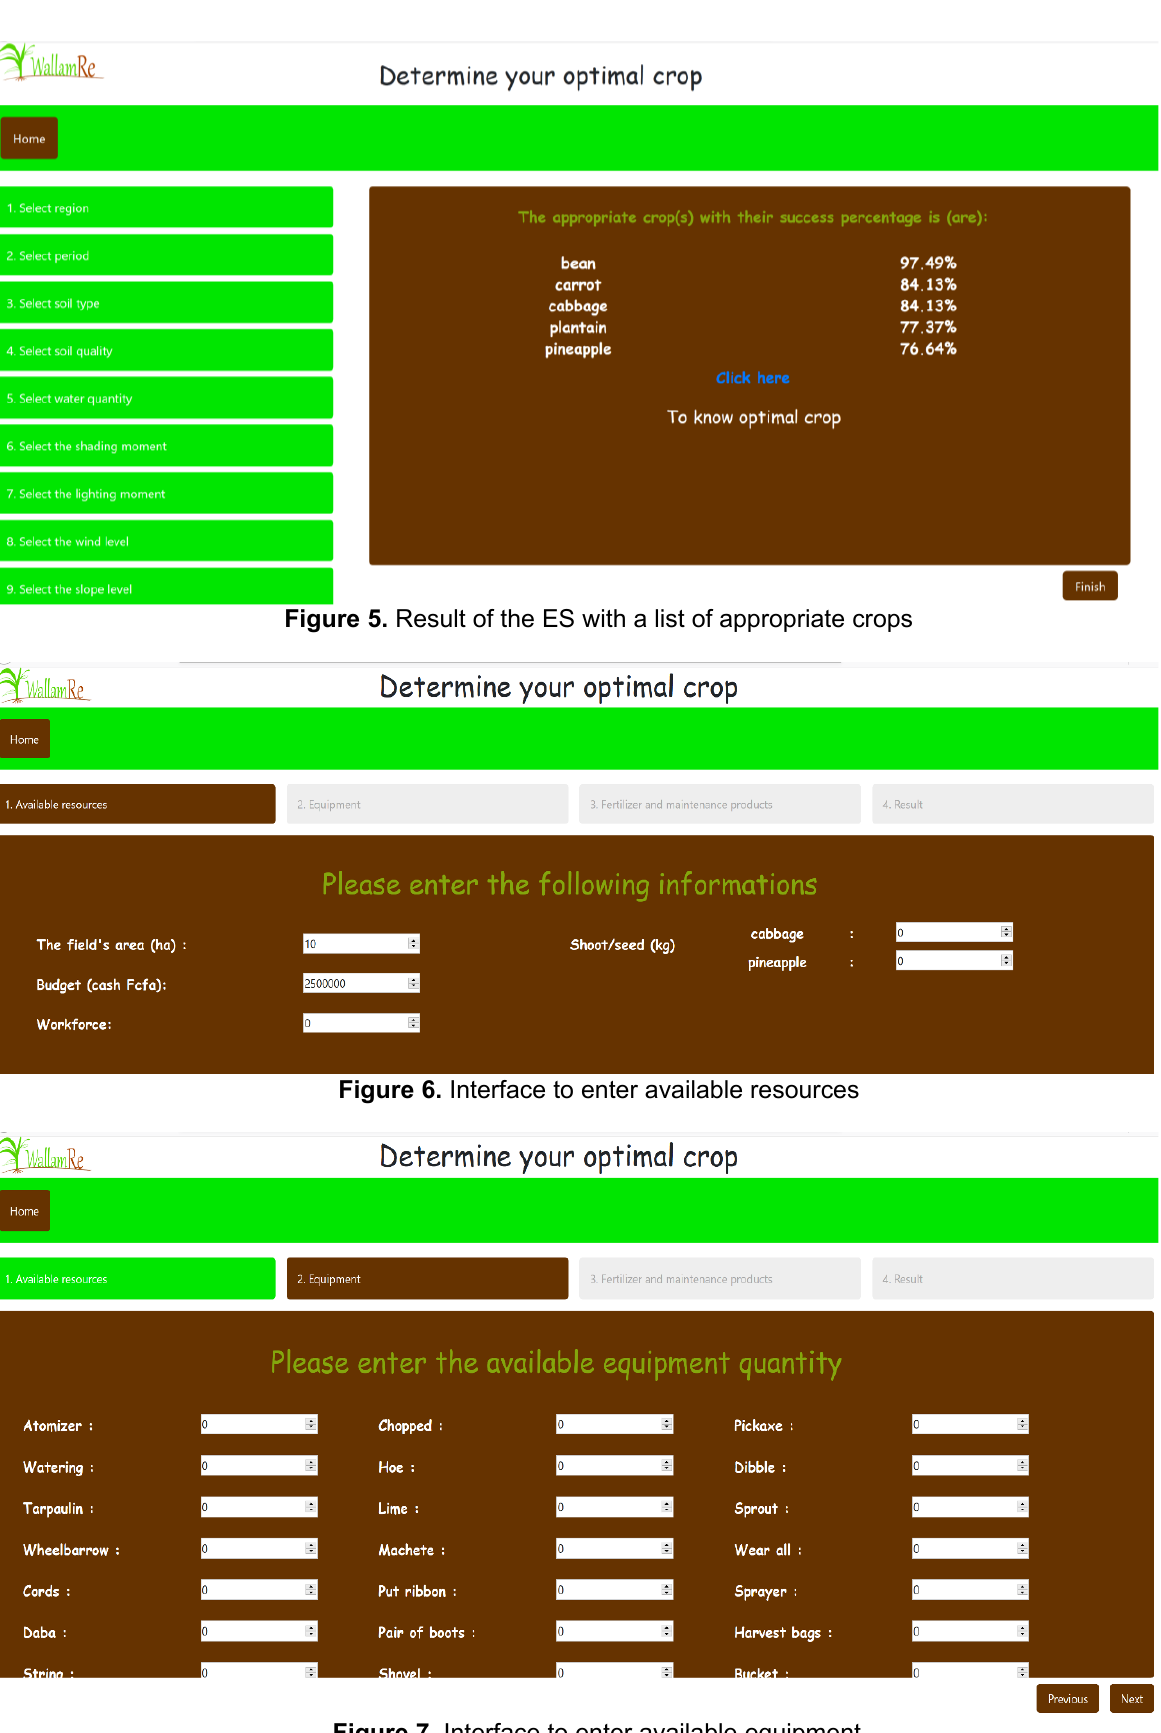
Figure 7. Interface to enter available